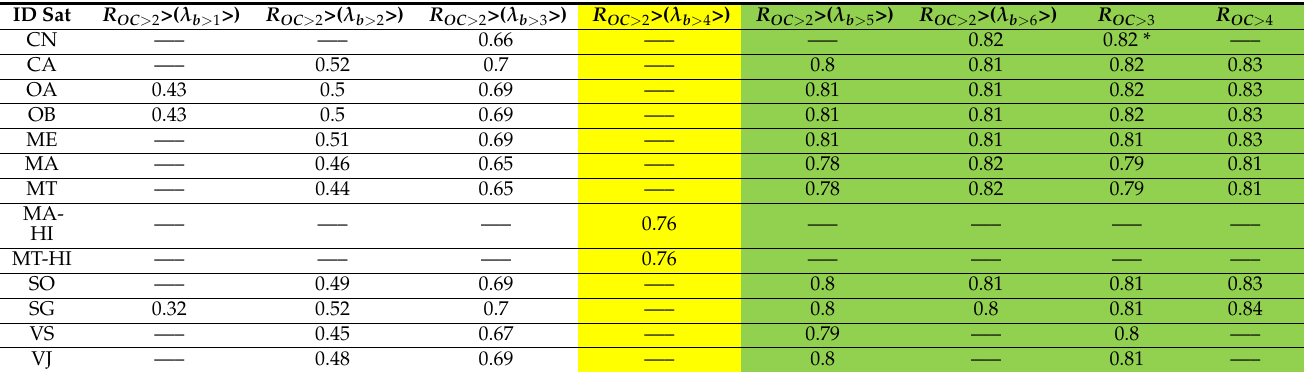
Table 6. R2L values for comparison between measured in situ chl-a concentration ( C ins ) and estimated remote sensed chl-a concentrations ( C rs ) calculated using Formula (8) for different band ratio indices. Columns with the best results are highlighted in green, and columns with mediocre, but acceptable results are highlighted in yellow.